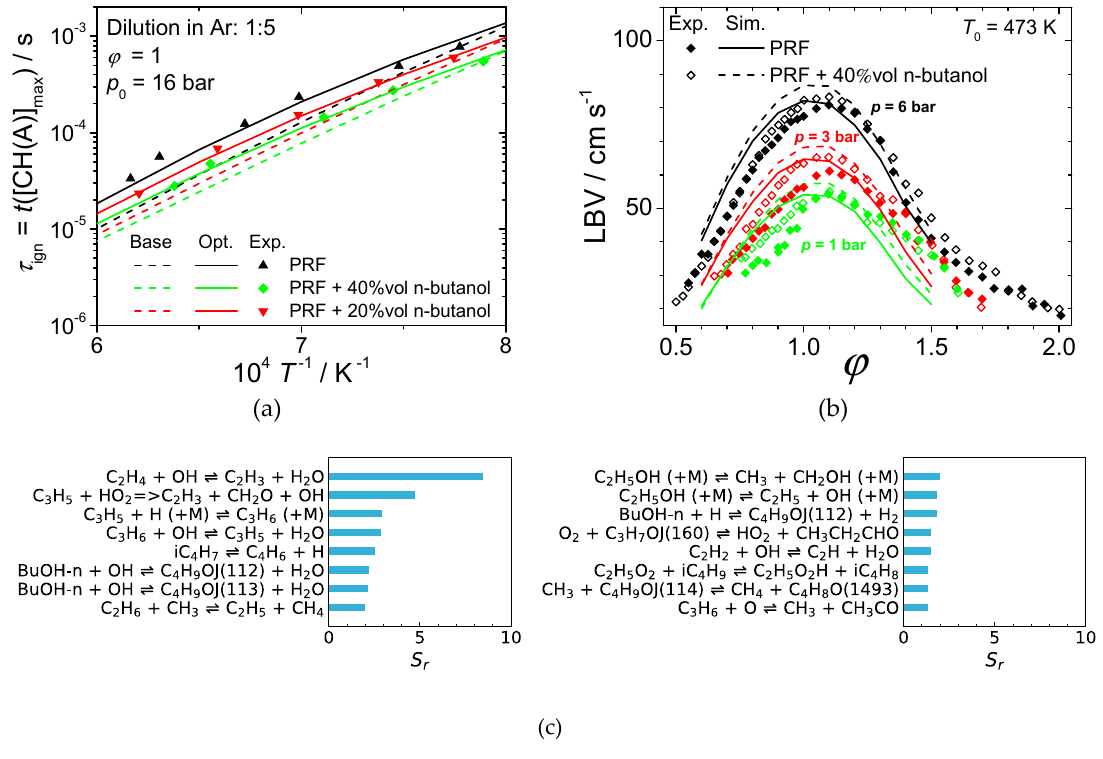
Figure 17. Ignition delay times τ ign ( a ), laminar burning velocities LBV ( b ) of PRF (ON 90) and its mixtures with n-butanol, and global sensitivity coefficients S r of the reactions on the ignition delay data ( c ); experimental data from [63].